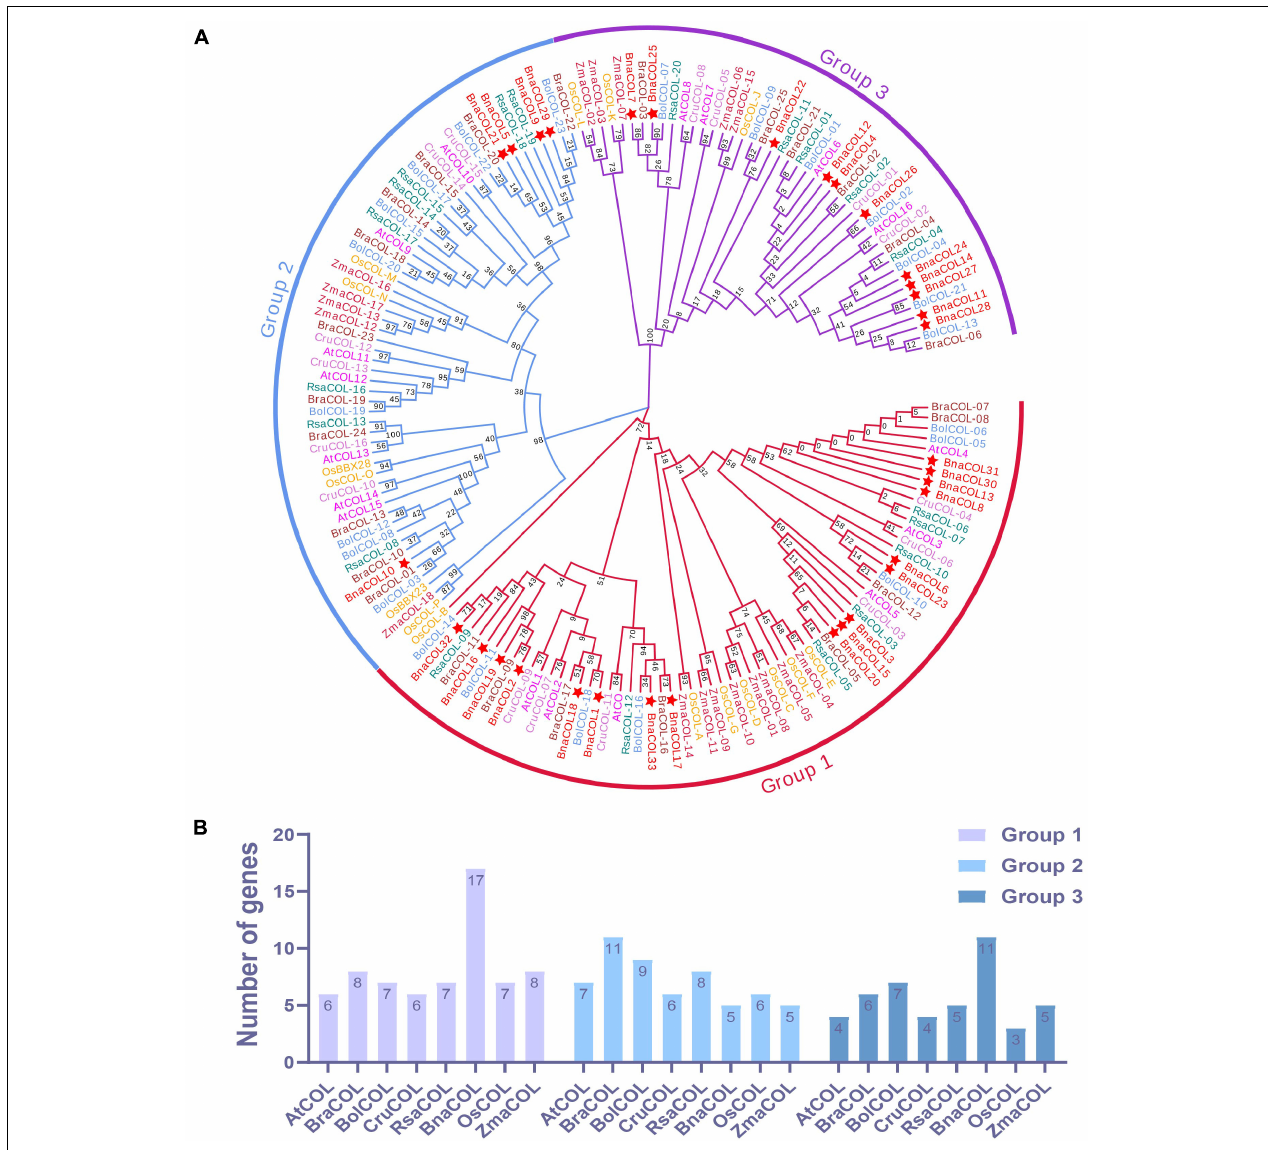
FIGURE 2 | Phylogenetic analysis and number statistics of COL homologs in different species. (A) Phylogenetic tree using 137 COL proteins from 7 species, including rice, maize, Arabidopsis , B. napus , B . oleracea , B. rapa , and radish . The clades of group 1, 2, and 3 are marked in red, blue, and purple, respectively. Among them, BnaCOLs are represented by red five-pointed stars. The abbreviations represent the species as follows: Os, Oryza sativa ; Zma, Zea mays ; At, Arabidopsis thaliana ; Bna, Brassica napus ; Bol, Brassica oleracea ; Bra, Brassica rapa ; Cru, Capsella rubella , and Rsa, Raphanus sativus . (B) Statistics of the number of COL genes in each group. The ordinate is the number of genes and the abscissa is the COL genes of each